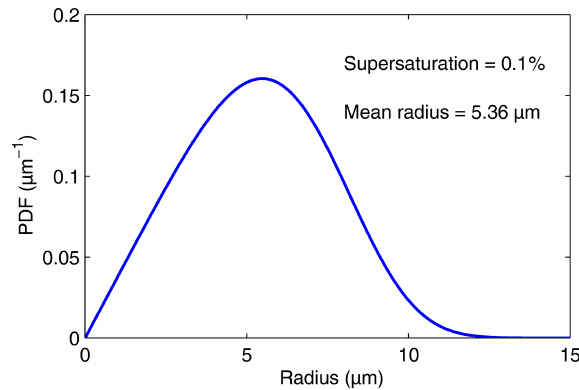
Figure 3. PDF of the droplet radius distribution given by Eq. (19) for a supersaturation of 0.1% and h = 1m.